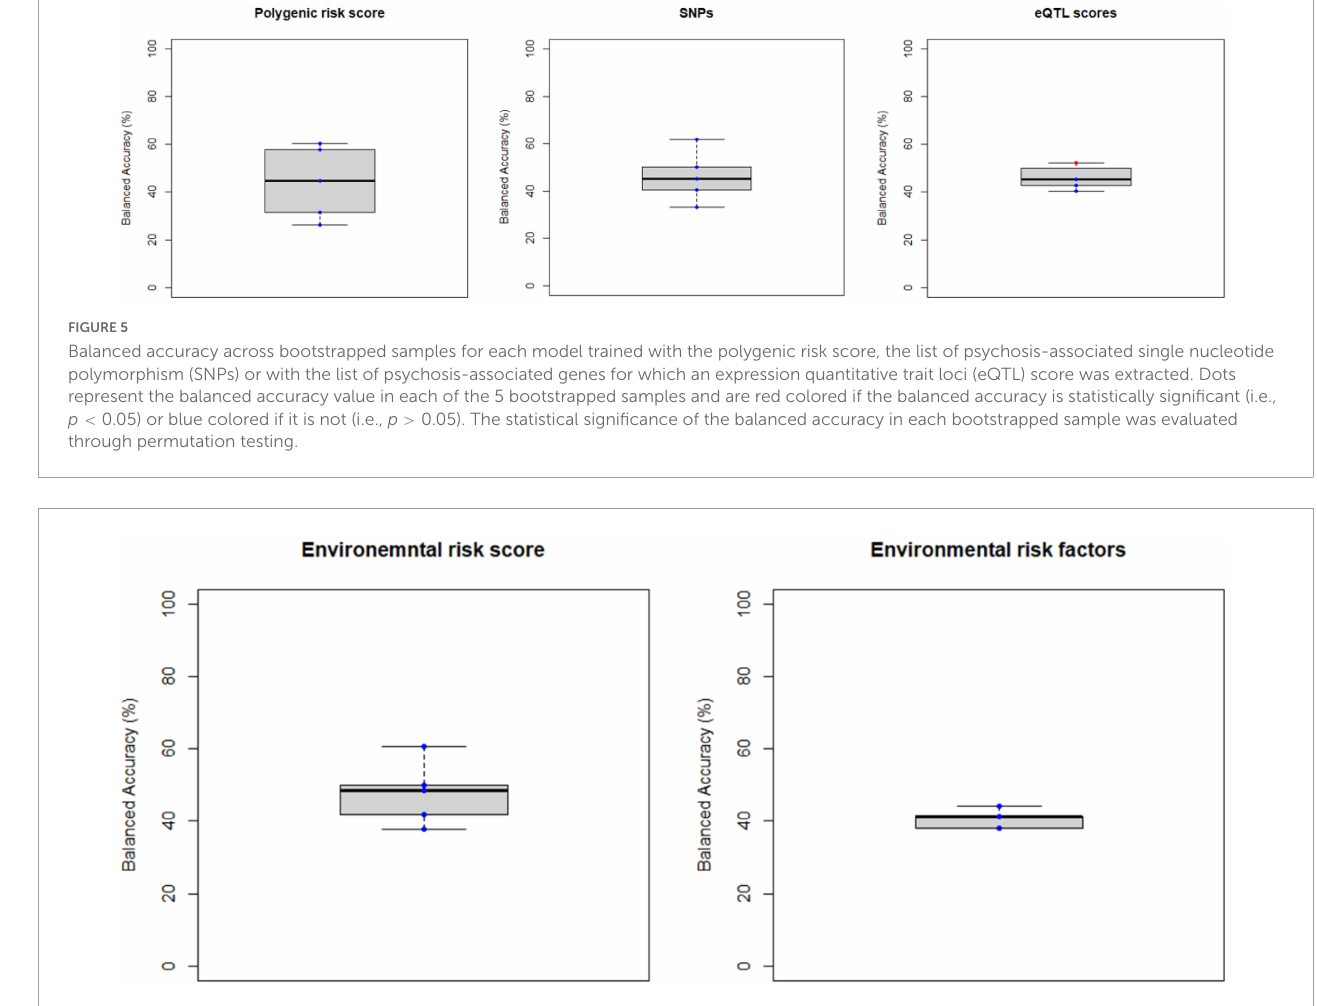
FEP patients from healthy controls (26) and ARMS-T from ARMS- NT (16), (b) a set of psychosis-associated SNPs previously